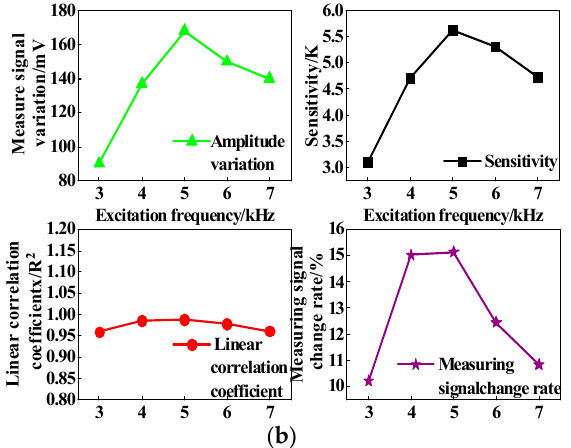
Figure 22. Influence of excitation frequency on the stress measurement signal. ( a ) Variation curve of probe measurement signal with a frequency. ( b ) Influence of excitation frequency on each characteristic quantity.